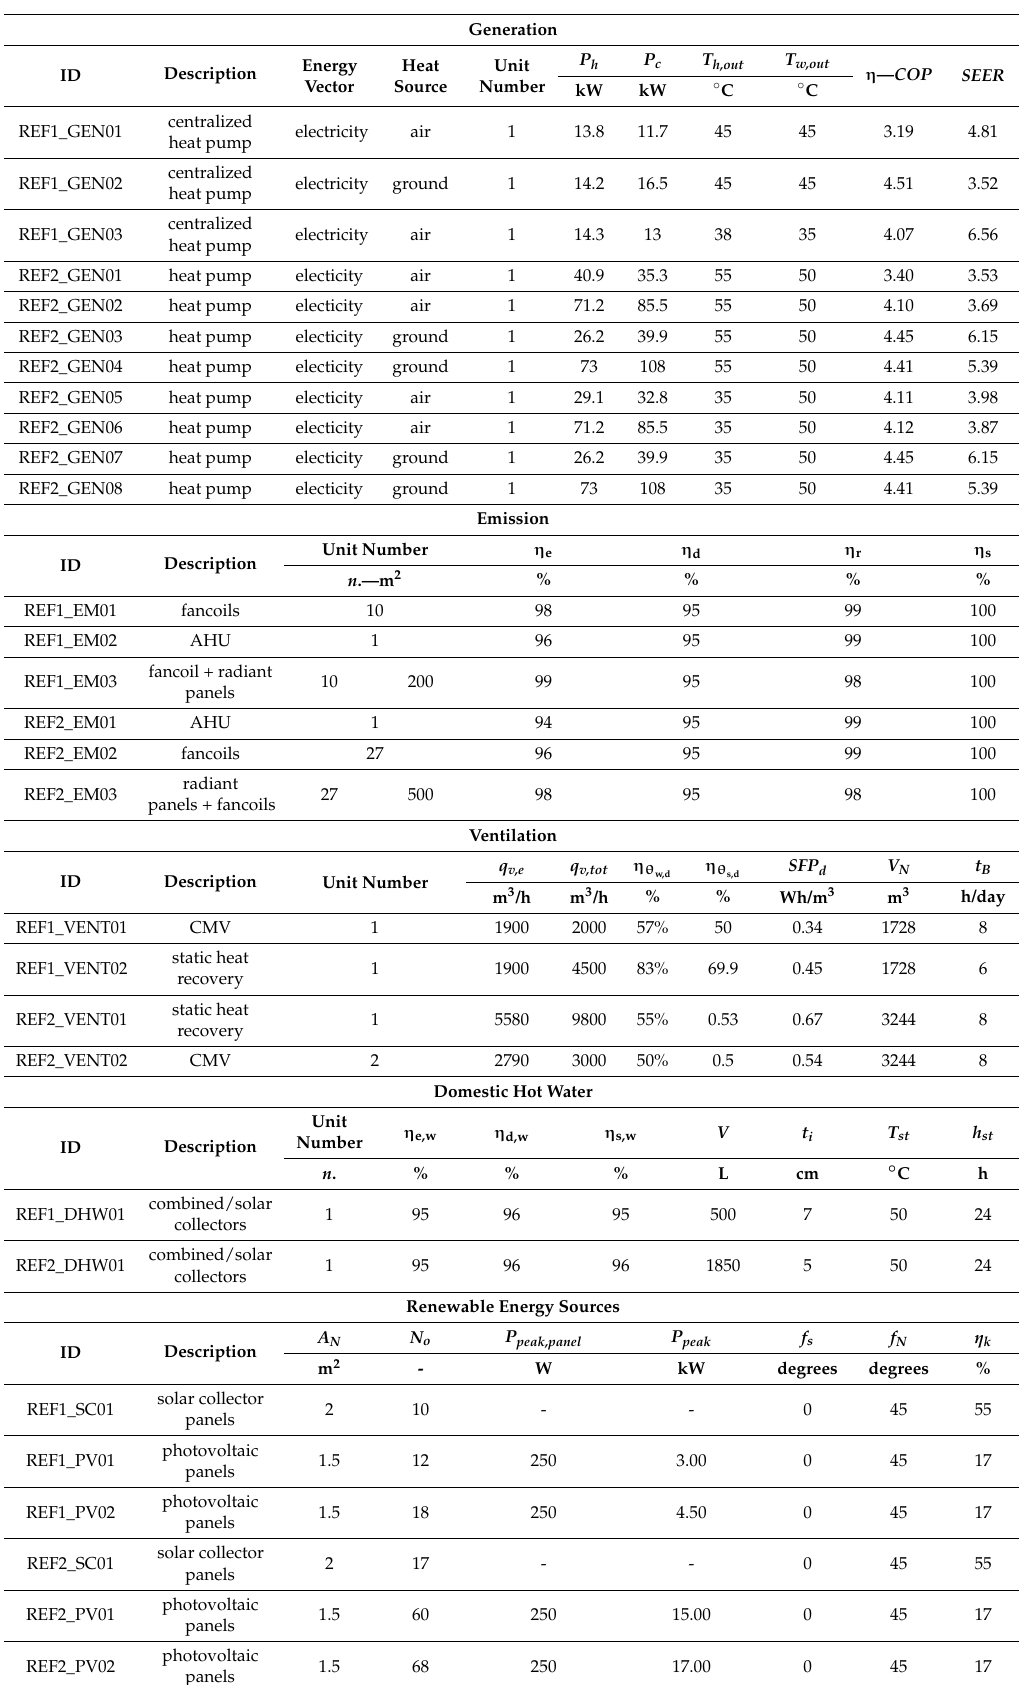
Table 5. Variants of technical systems of reference